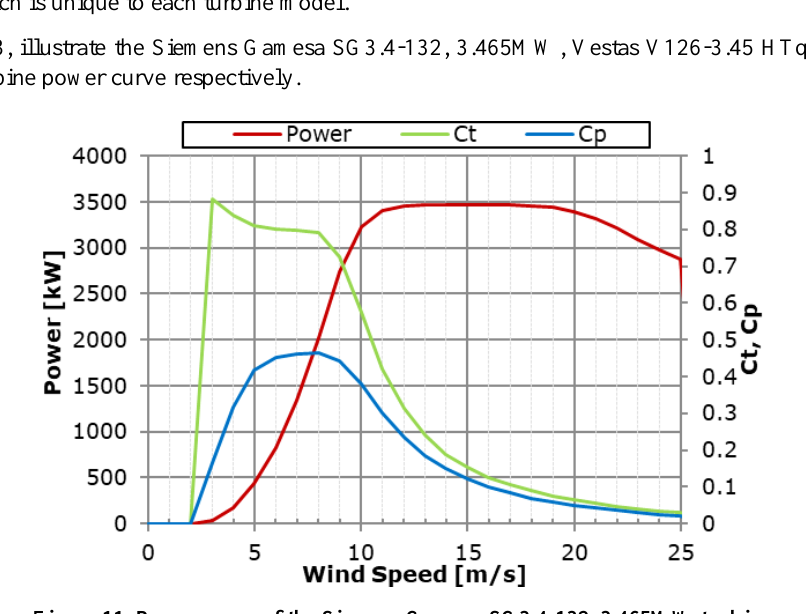
Figure 11. Power curve of the Siemens Gamesa SG3.4-132, 3.465MW